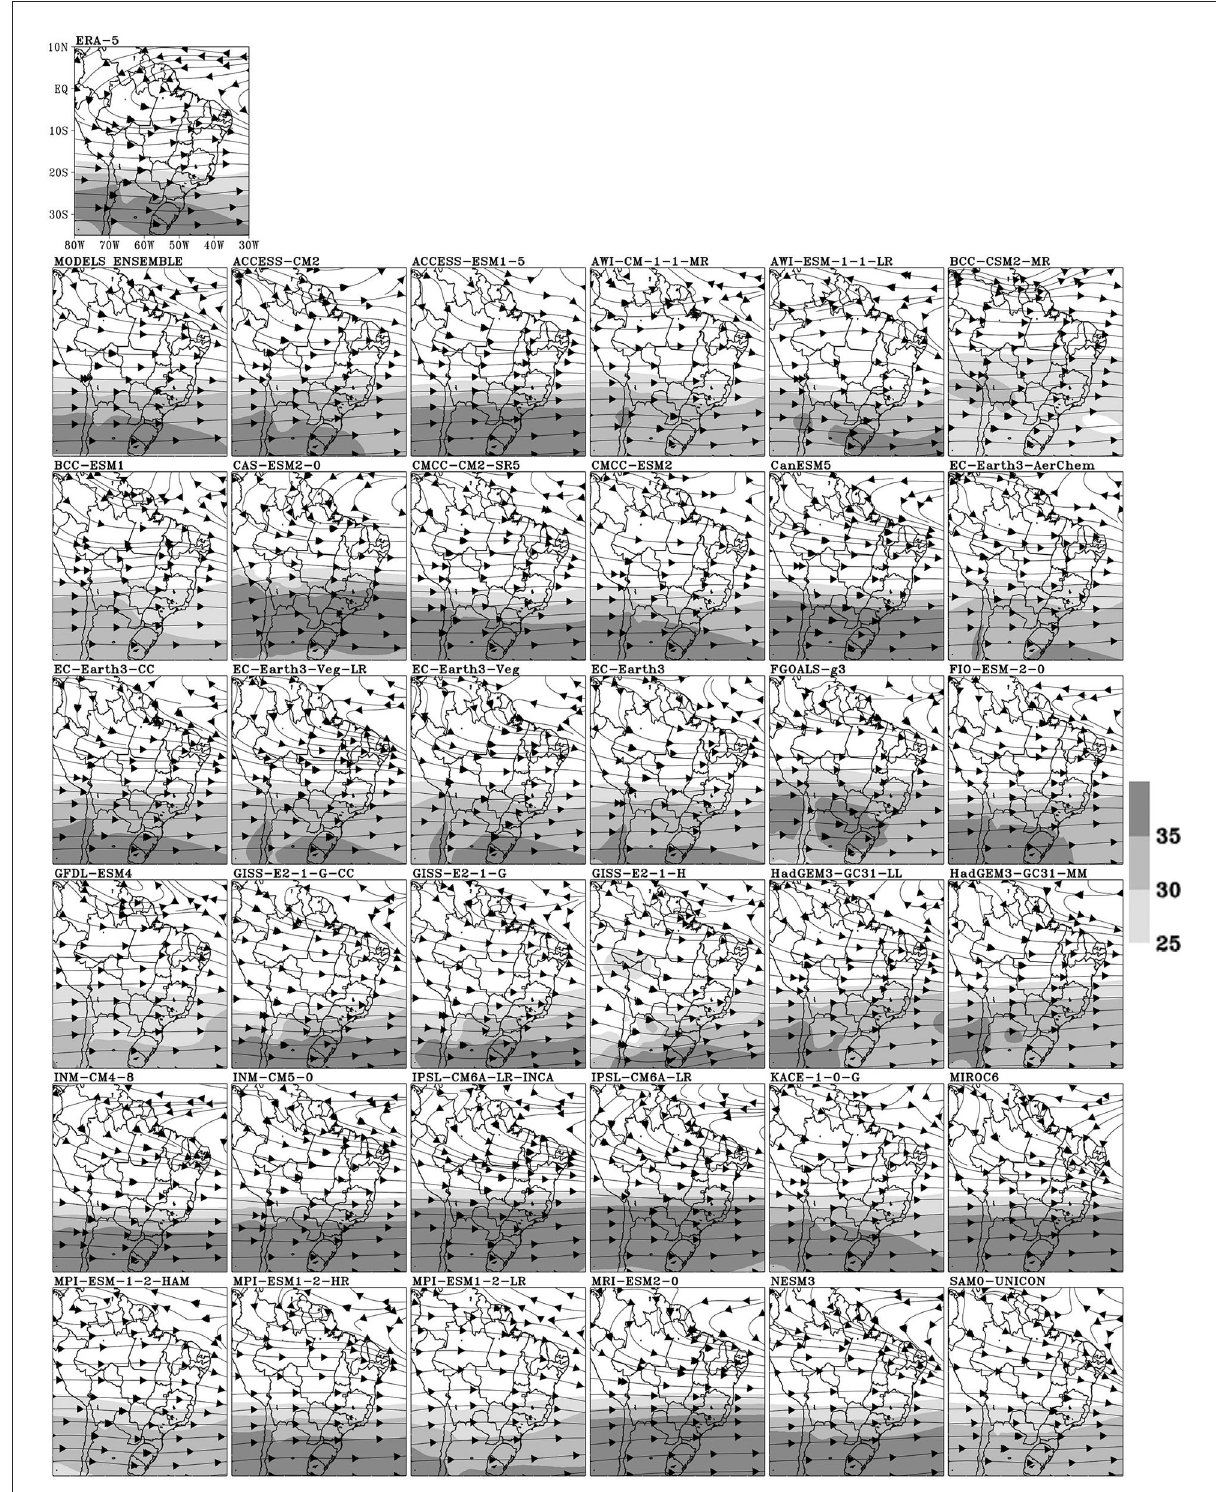
FIGURE5 Streamlines and magnitude of climatological winds (m/s) at 200 hPa simulated by the multi-model ensemble mean, individual CMIP6 models, and ERA-5 reanalysis (top left) for austral winter (JJA) during the historical period. The shaded regions represent wind magnitude starting from 5 m/s while the vector shows the wind